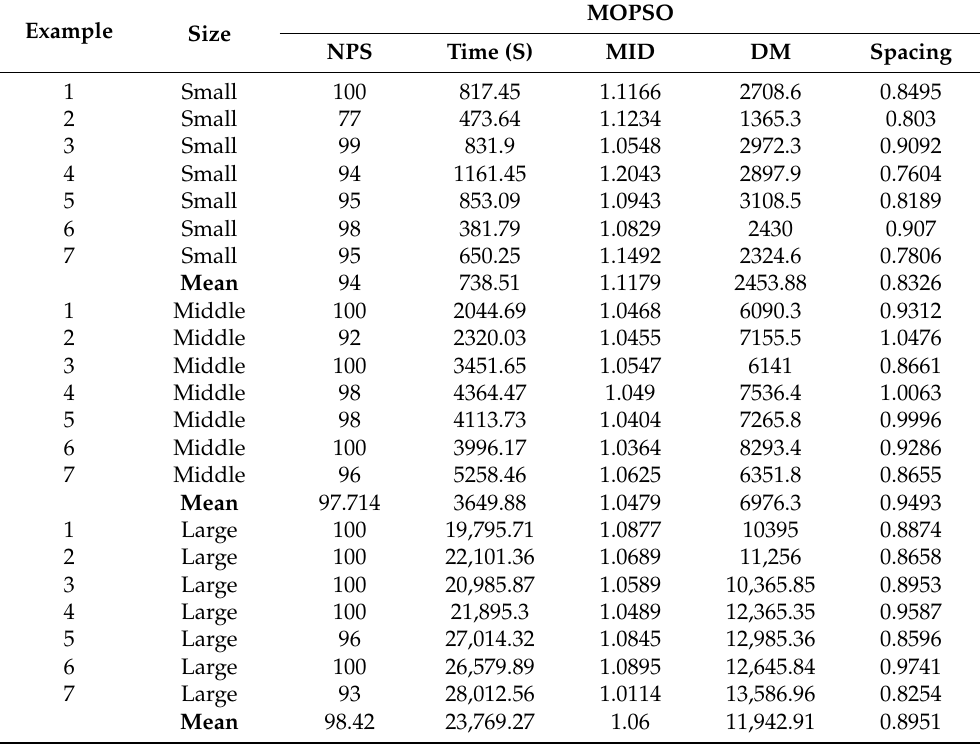
Table 20. Criteria values of the MOPSO